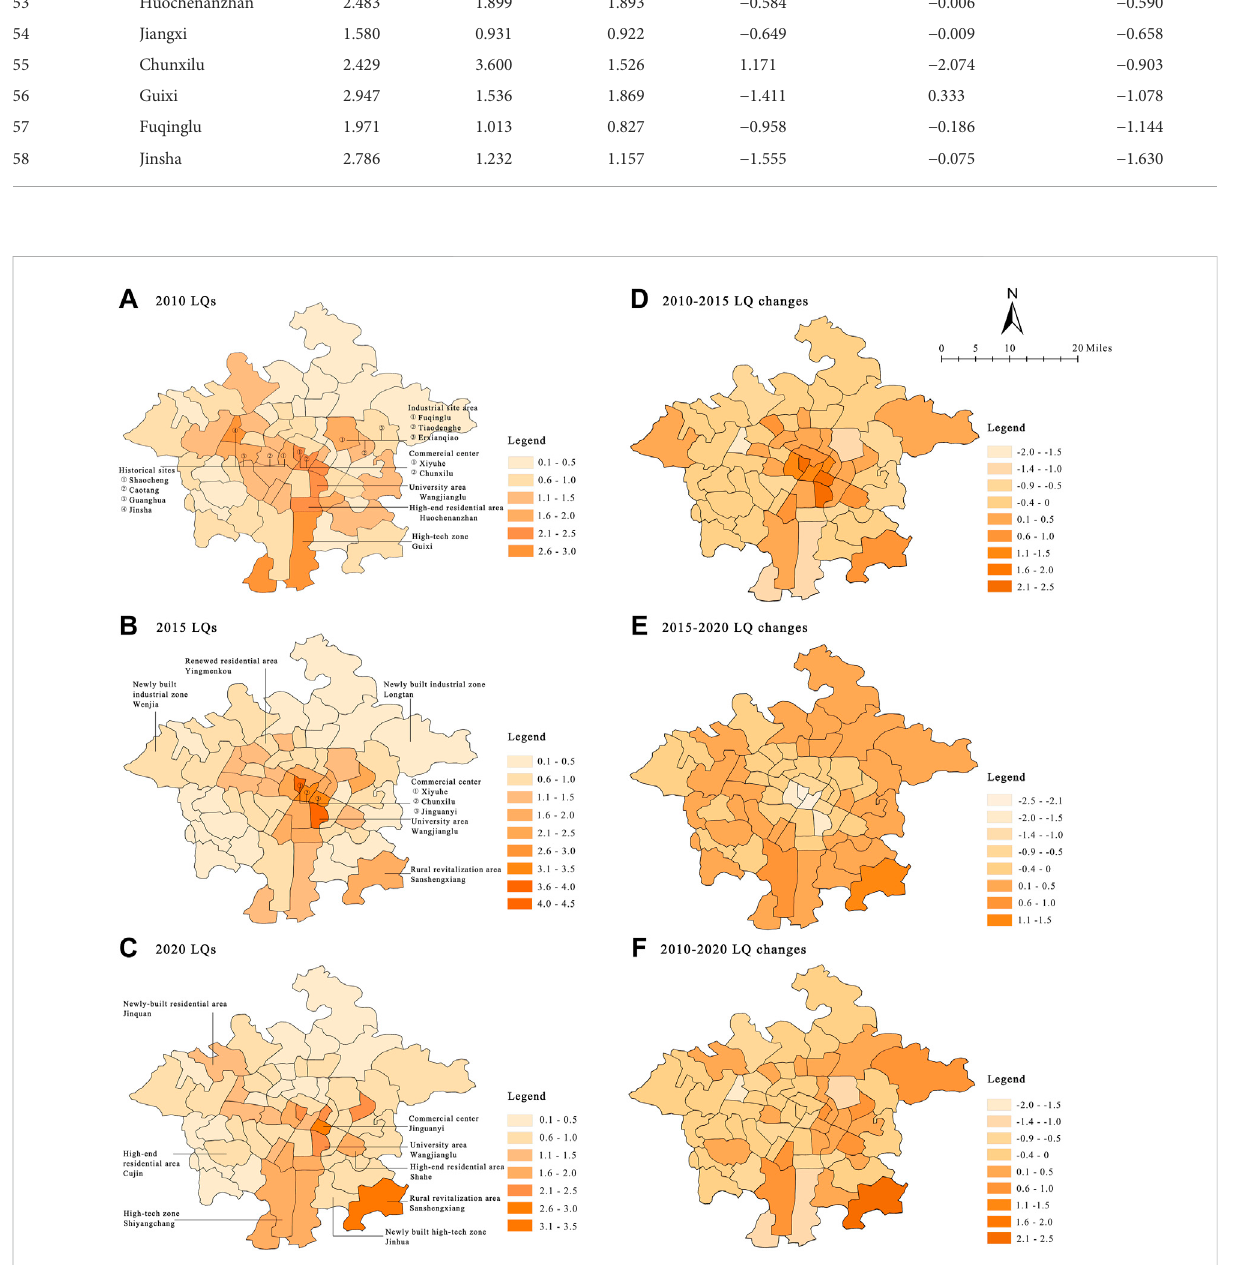
FIGURE 3 The LQs of spaces for emerging consumption in Chengdu from 2010 to